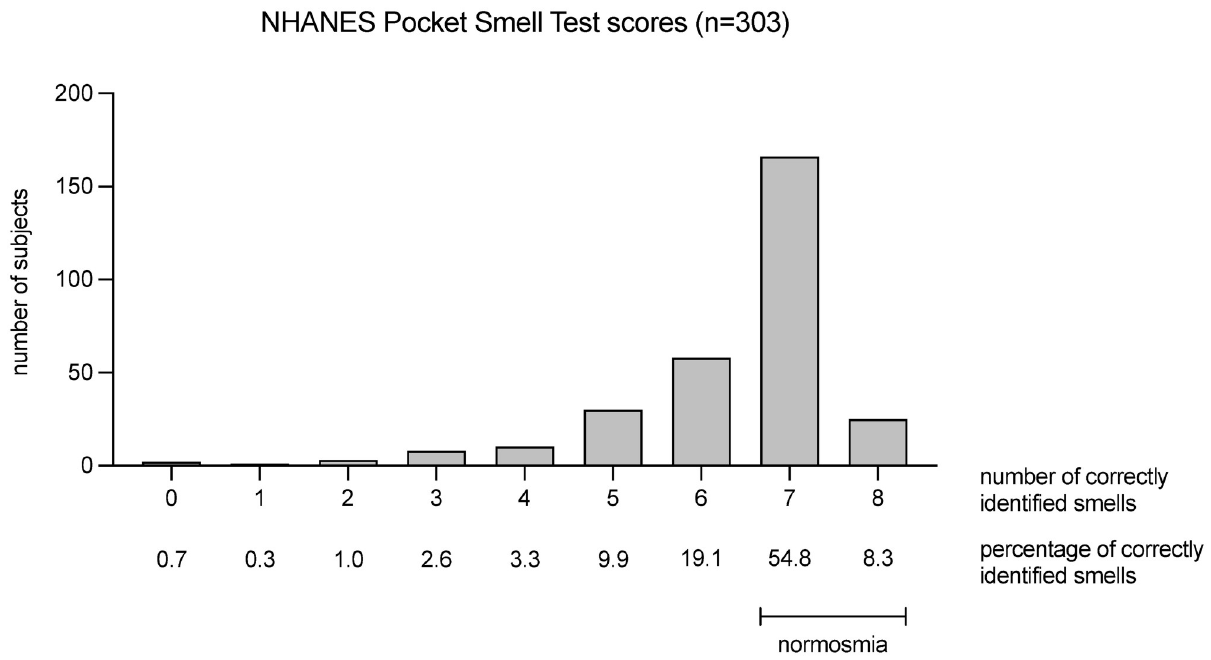
Fig 1. Results of olfactory test. Histogram of the NHANES Pocket Smell Test score as number of correctly identified smells, and percentage of the total study population. Normosmia is defined as six or more correct answers and hyposmia as five and less correct answers [18].